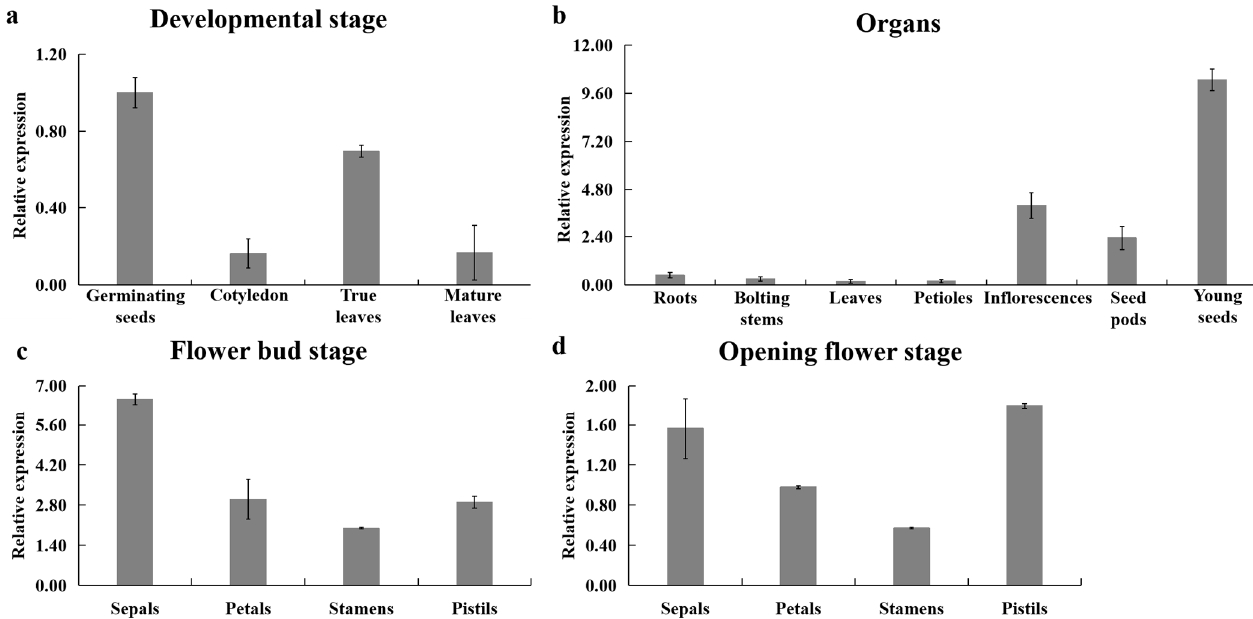
Figure 2. Relative expression levels of BoaNXS in different developmental stages ( a ), organs ( b ), and flower tissues in flower bud stage ( c ) and opening flower stage ( d ) of Chinese kale. The expression level of BoaNXS in germinating seeds was set as 1.